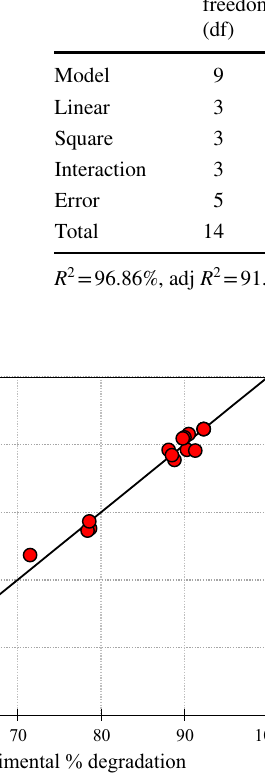
Table 3 Analysis of variance (ANOVA) results for the response surface